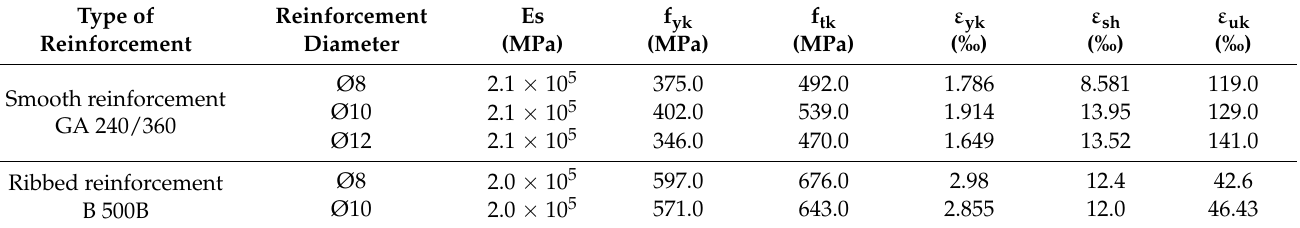
Table 3. Performance of